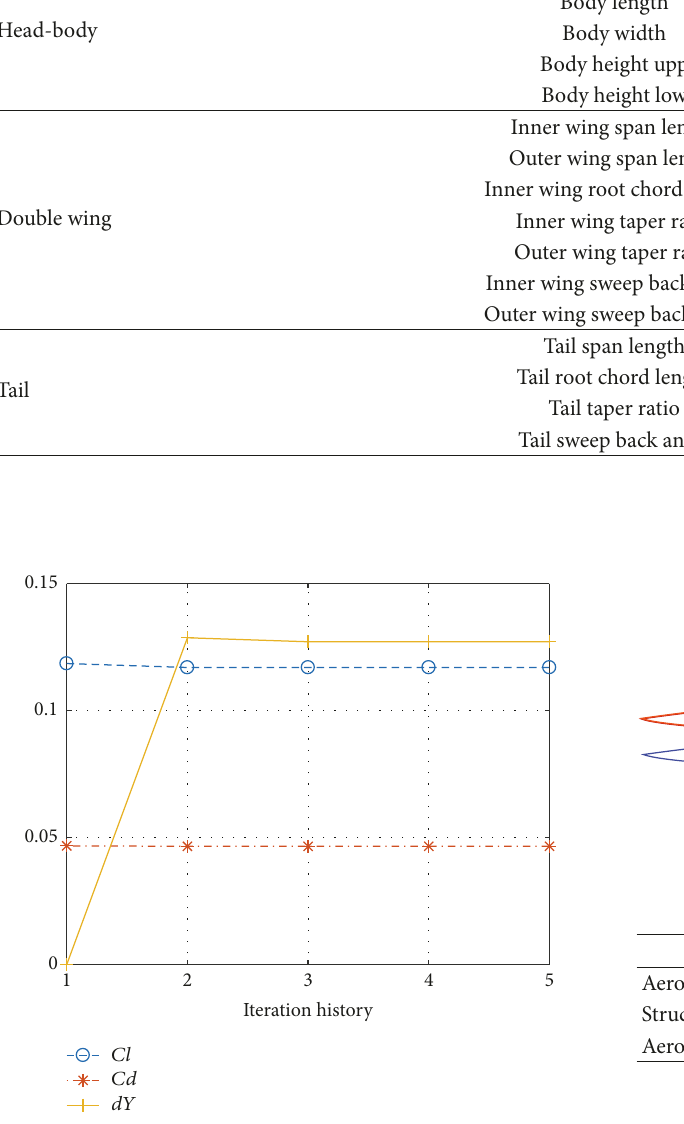
Figure 12: Iteration history of the lift coefficient 𝐶𝑙 , the drag coefficient 𝐶𝑑 and the maximum deformation in the 𝑌 direction 𝑑𝑌 .